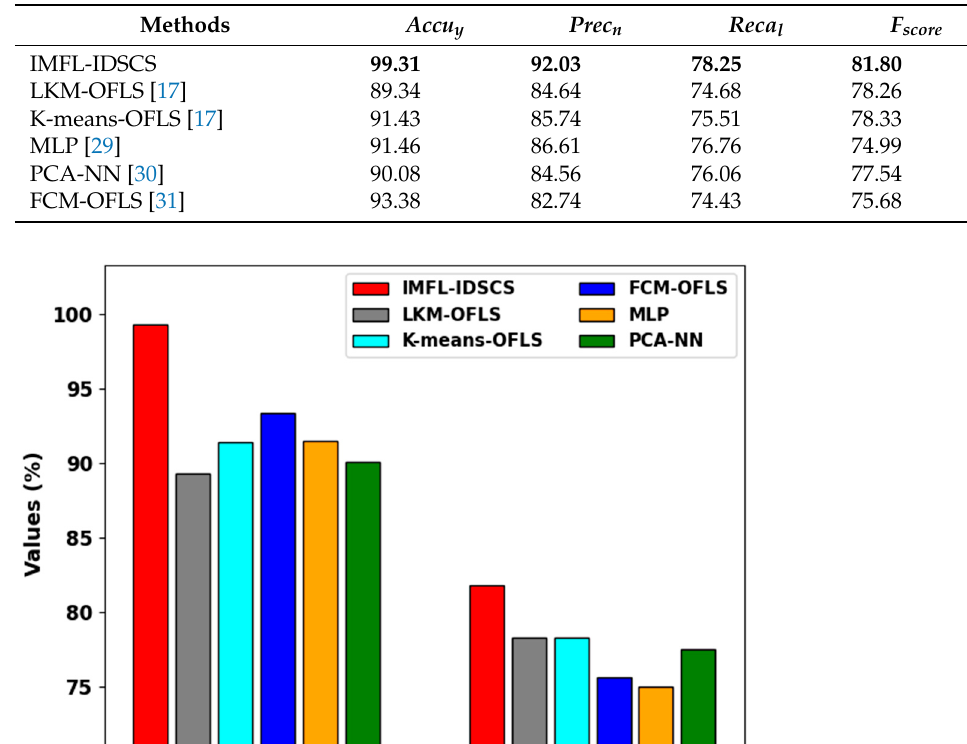
Figure 9. ROC curve analysis of IMFL-IDSCS system. Table 4. Comparative analysis of IMFL-IDSCS system with other approaches.